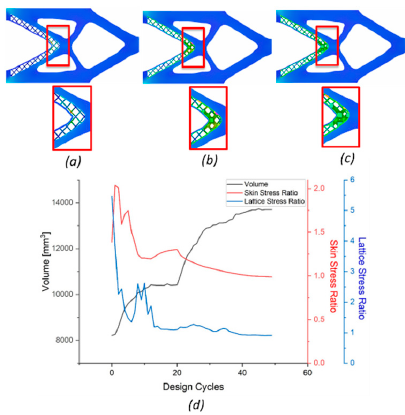
Figure 8. Lattice optimization iterations and the evolution of the lattice thickness in iterations 1, 10 and 49 shown in ( a ), ( b ) and ( c ) respectively; ( d ) the convergence history of the optimization.